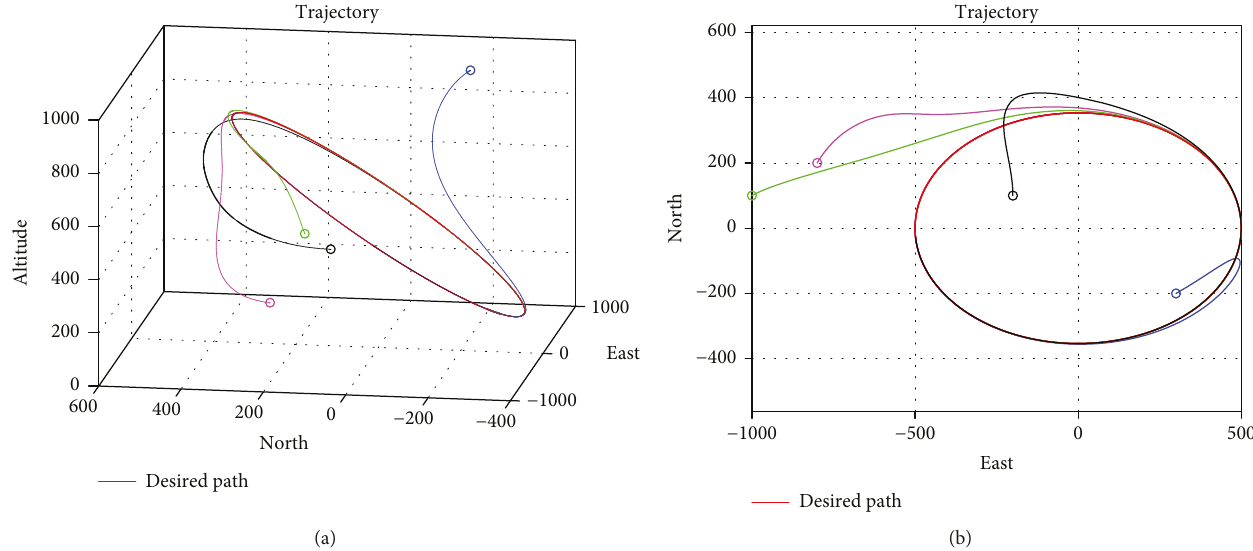
Figure 14: Path following with an oblique circle (with inclination angle of 45 degree). (a) Three-dimensional view, (b) planar view.